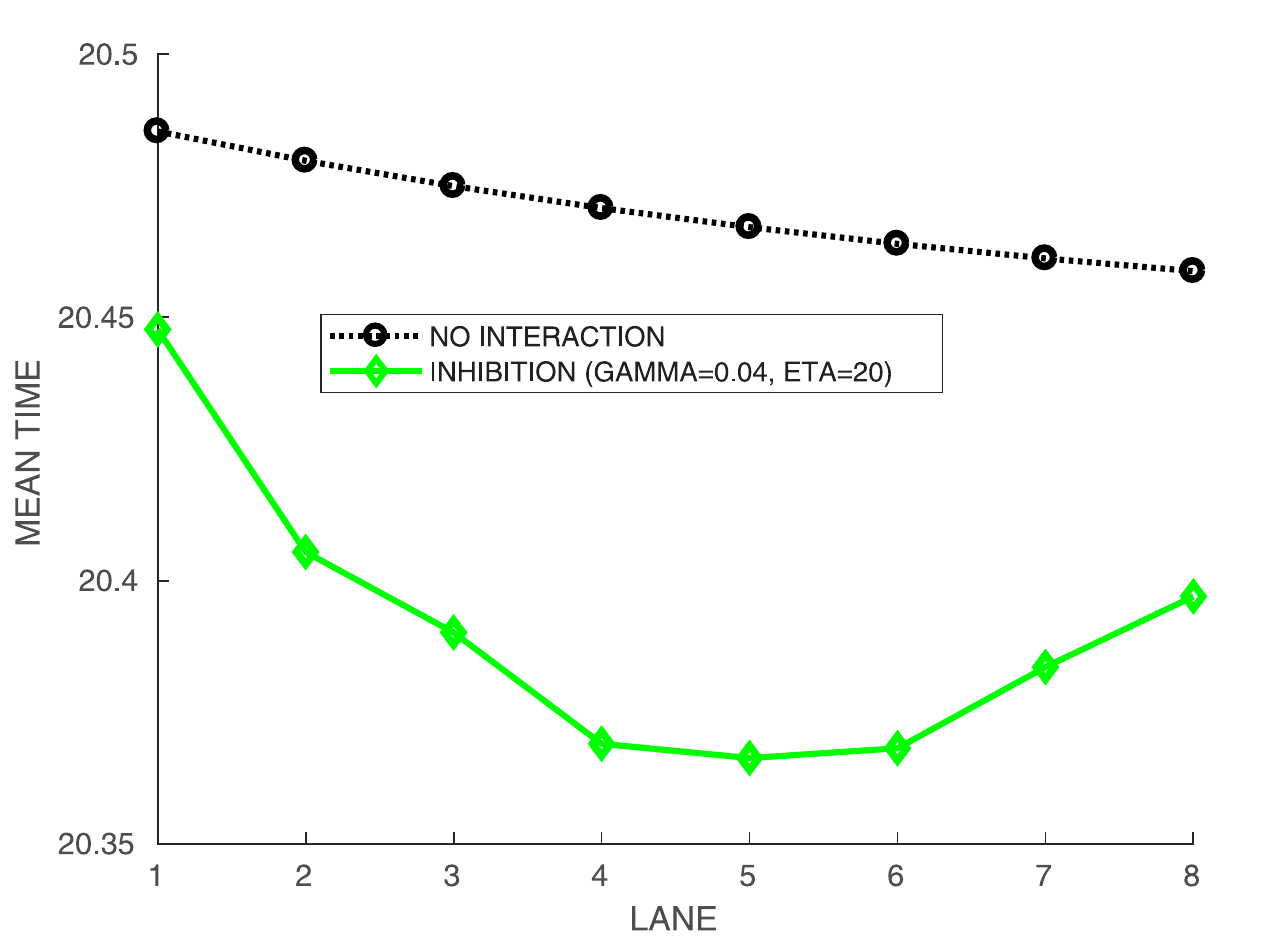
Fig 11. Mean times per lane for runner A 1 when in lane i vs himself in all other lanes. Without interaction ( γ = 0), and with interaction γ = 0.04, η = 20. Lane performance (sorted by mean time): � T